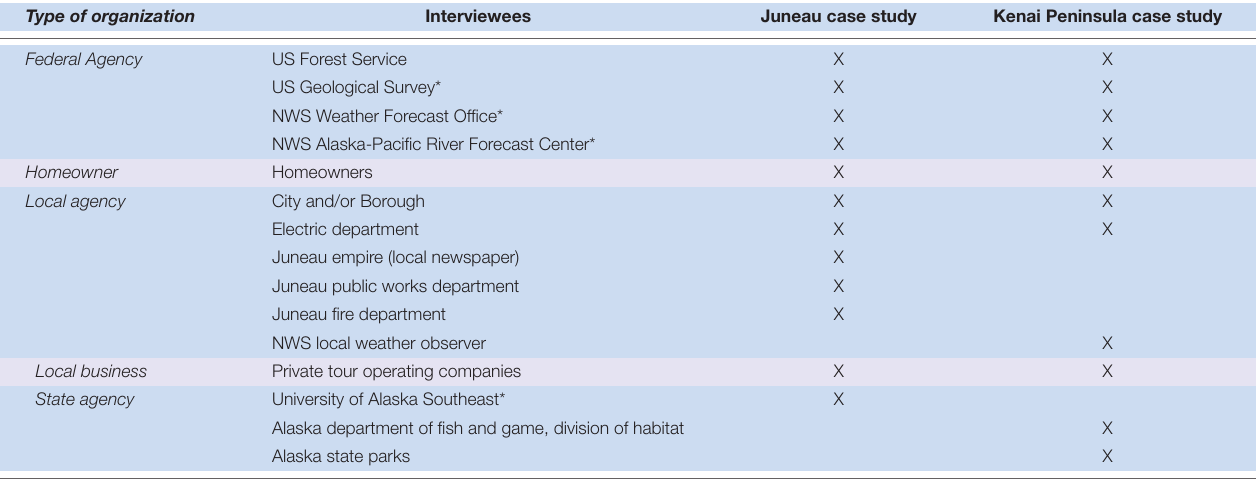
TABLE 1 | Interviewees by type of organization and case